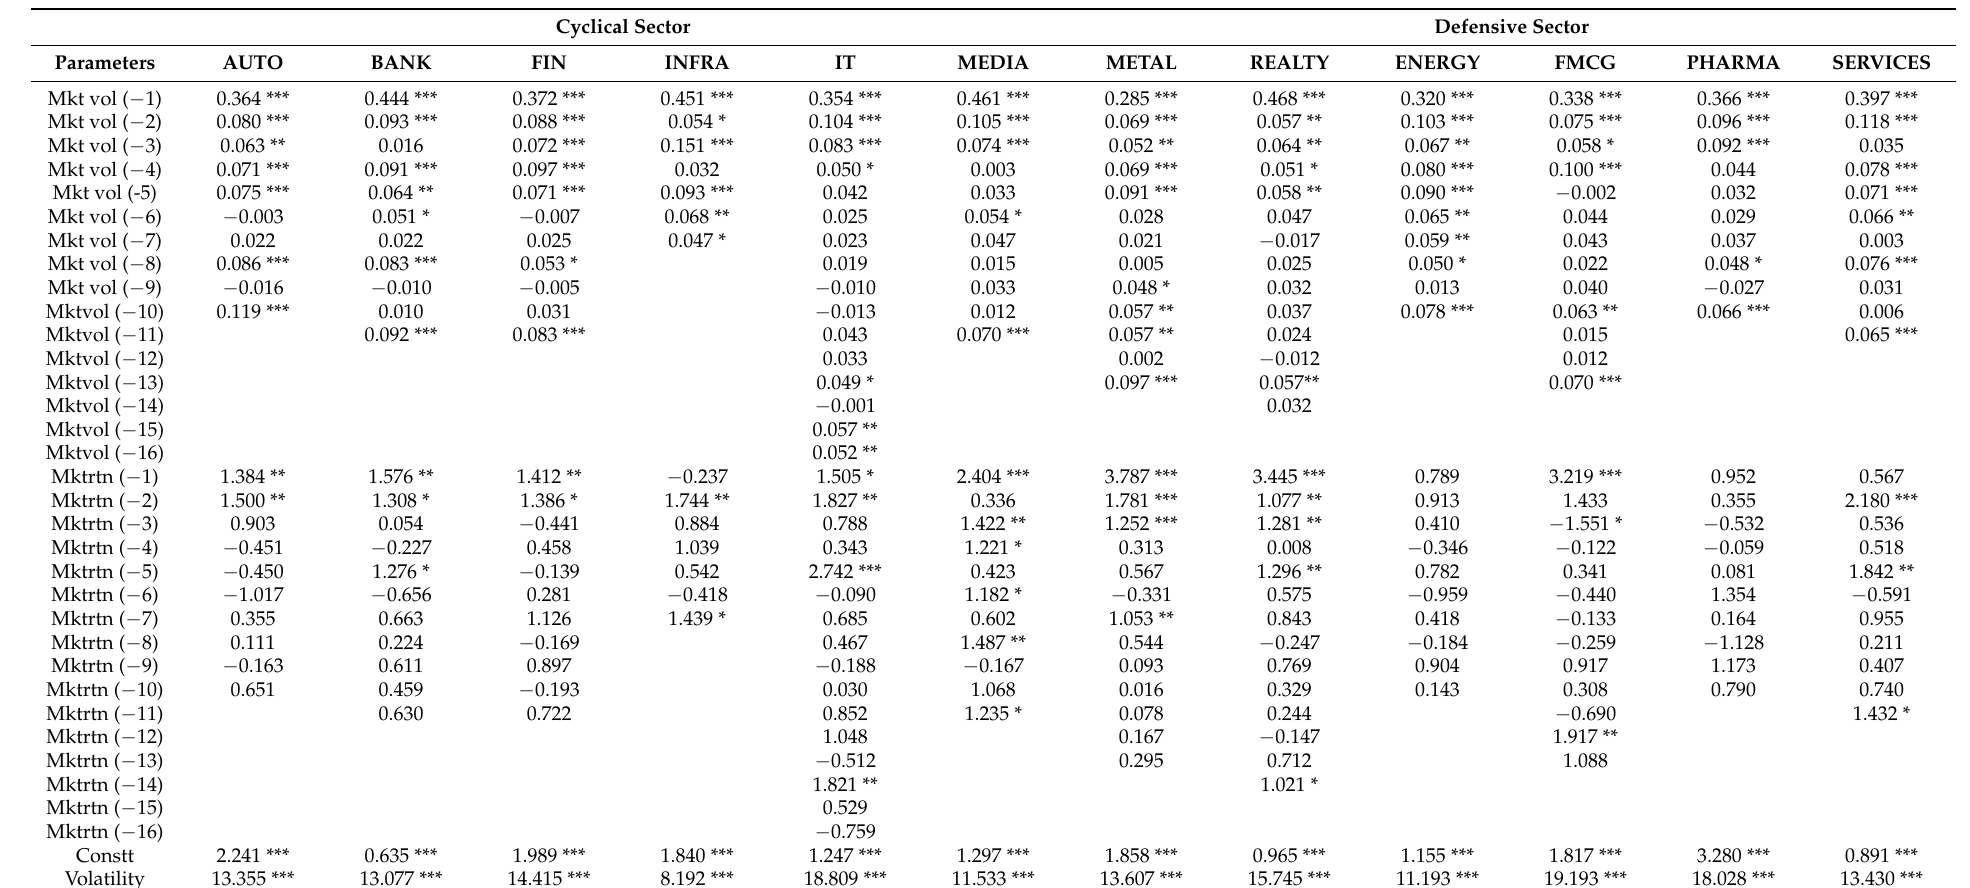
Table 2. VAR results for pre-COVID-19